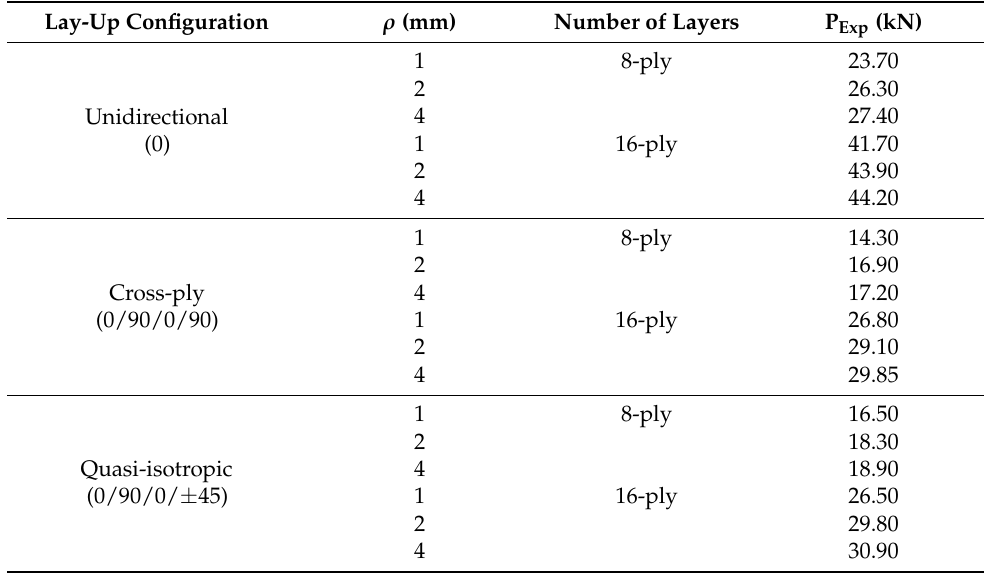
Table 3. Experimental critical loads of U-notched specimens for each lay-up configuration [21]. Lay-Up